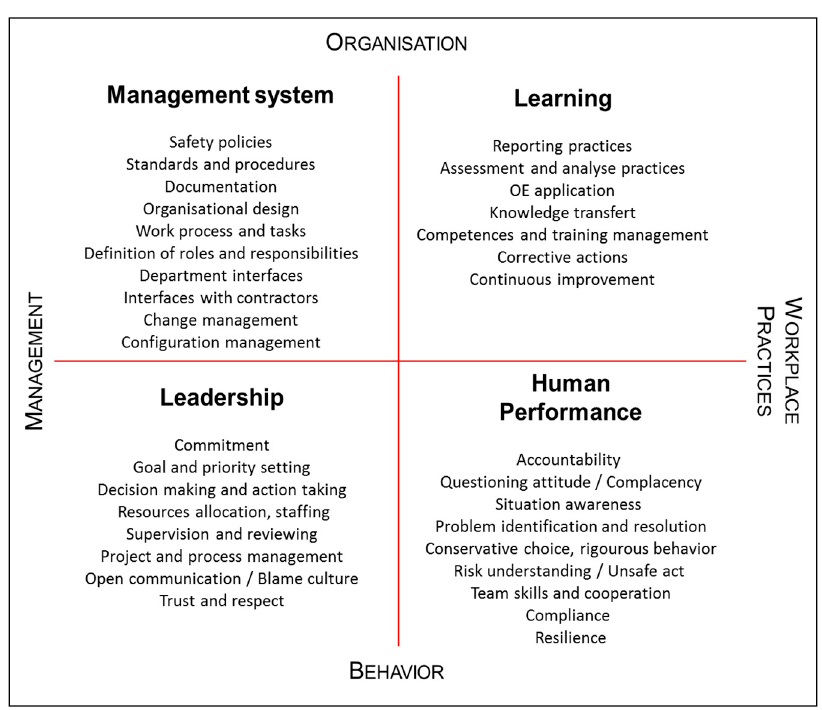
Figure 2. Key dimensions for safety culture assessment.